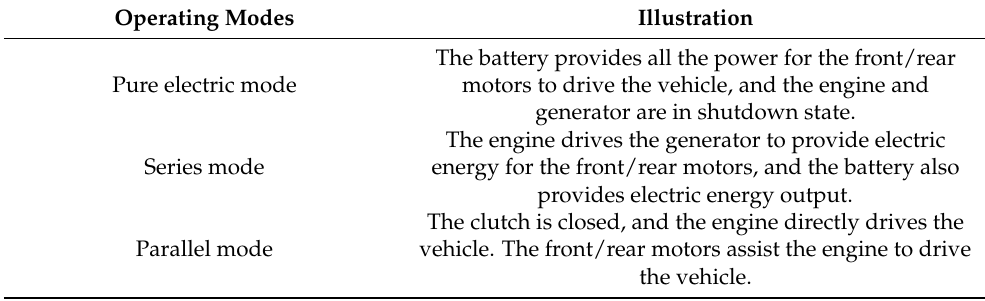
Table 3. Operating states of vehicle components under different modes.